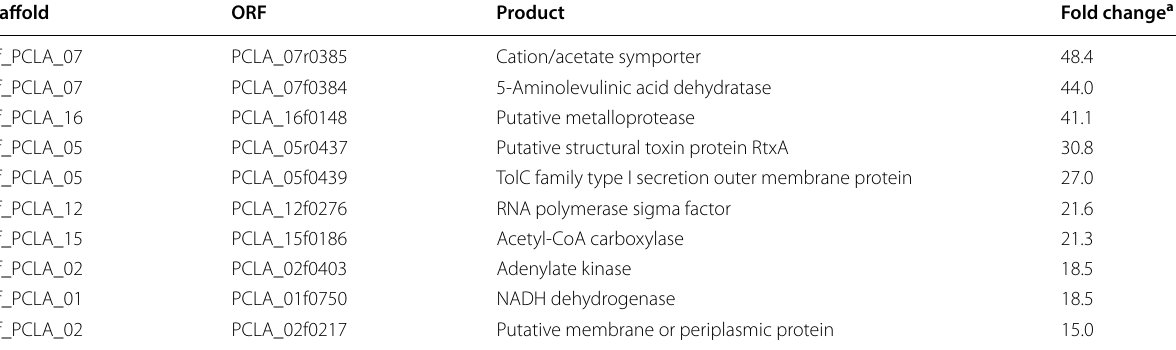
Table 1 The ten most up-regulated genes of Pseudomonas citronellolis LA18T with levulinic acid Scaffold